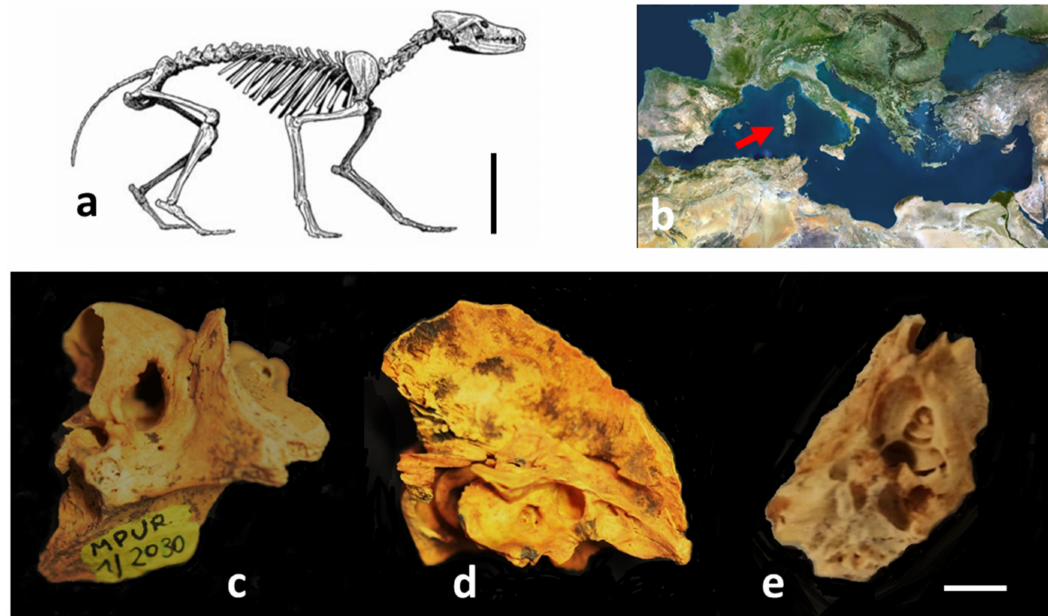
Figure 1. ( a ) Skeleton of Cynotherium sardous (Reprinted with permission from Ref. [22]. 1970 Mem. Ist. It. Paleontol Um, modified), scale bar = 20 cm; ( b ) the arrow indicates the island of Sardinia in the Mediterranean Sea; ( c – e ) portion of temporal bone in lateral view ( c ), medial view ( d ), and after microdissection ( e ), scale bar = 3